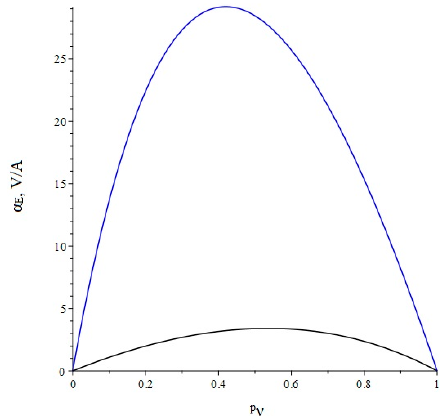
Figure 3. Theoretical dependence of the ME voltage coefficient on the volume fraction of the piezoelectric. Black color of the line is PZT, blue is LN cut y + 128°.